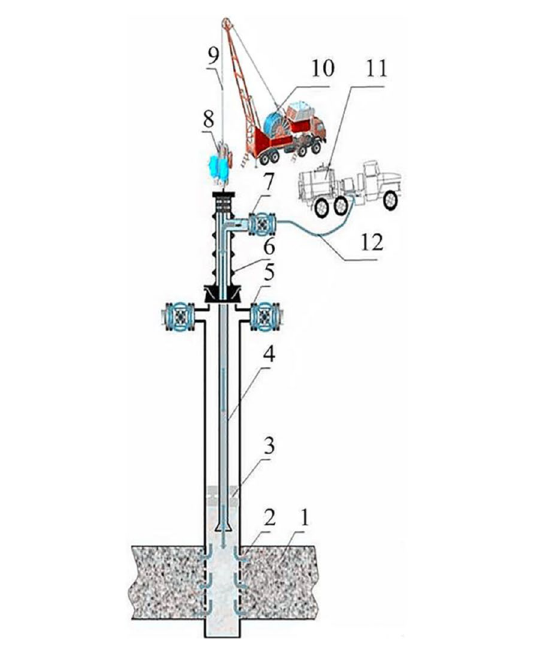
Fig. 3 Schematic diagram of ultrasonic-assisted oil recovery (Mul- lakaev et al. 2017): (1) oil formation; (2) ultrasonic downhole tool; (3) packer; (4) tubing; (5) casing valve; (6) lubricator; (7) discharge line; (8) umbilical cable feed; (9) umbilical cable; (10) wire line truck ПКC-5; and (11) pump unit CИH-32, 12-house